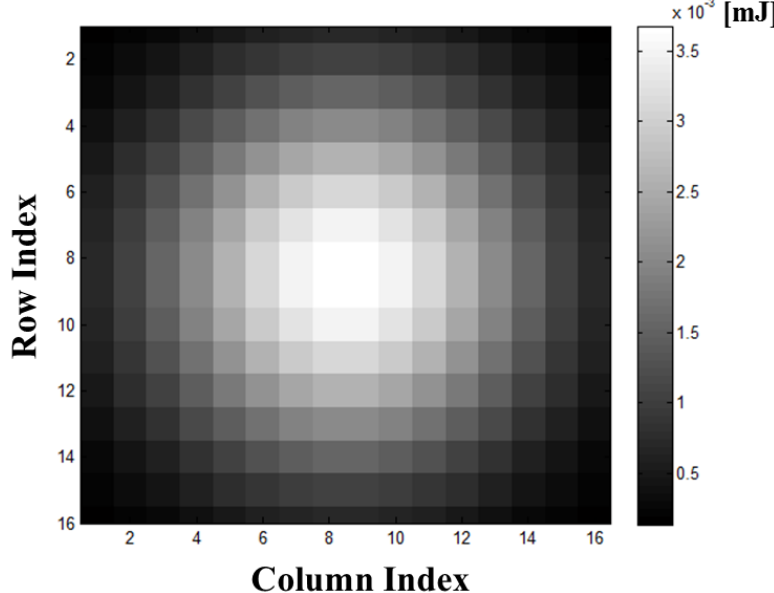
Figure 9. Intensity distribution of a simulated Gaussian beam profile with the array of 16 × 16, pulse energy of 0.4 mJ and 4.8 mrad beam divergence. Normalizing by the sum of Gaussian model and multiplying the pulse energy, we considered the energy loss due to the difference between array size of detector and beam width.